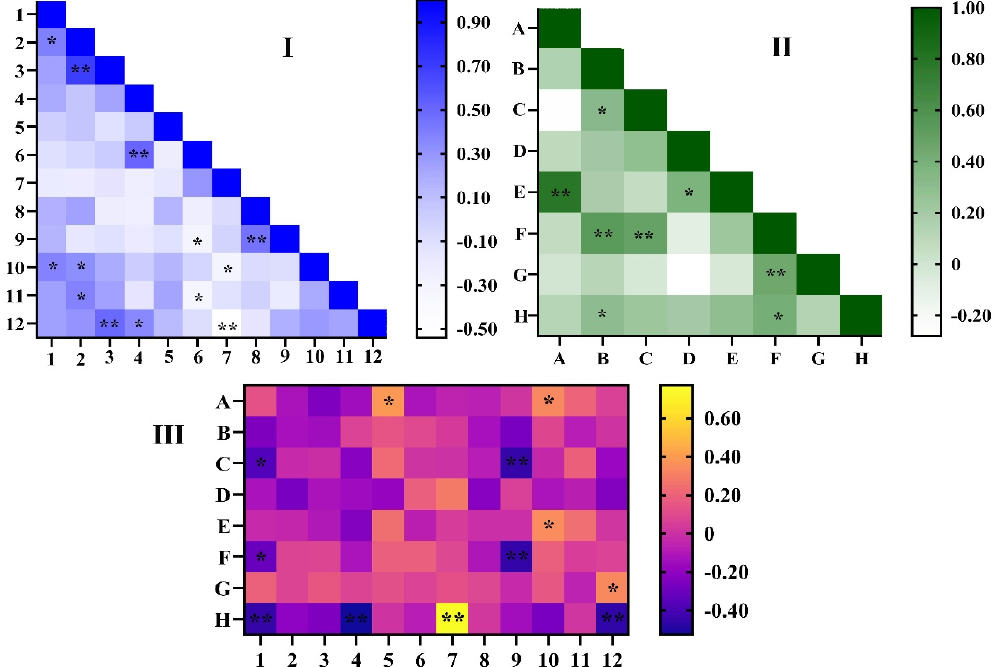
Figure 2. Correlation analysis between quality traits of H. acerba germplasms. ** indicated very significant correlation ( p < 0.01), * indicated significant correlation ( p < 0.05). Ⅰ : Correlation analysis between infructescence quality traits of H. acerba germplasms; Ⅱ : Correlation analysis between fruit quality traits of H. acerba germplasms; Ⅲ : Correlation analysis between infructescence and fruit quality traits of H. acerba germplasms. 1: Infructescence fat content; 2: Infructescence protein; 3: In ‐ fructescence tannin; 4: Infructescence total flavonoid; 5: Infructescence total saponin; 6: Infructescence soluble sugar; 7: Infructescence reducing sugar; 8: Infructescence starch; 9: Infructescence Mn; Fruit tannin; D: Fruit total flavonoid; E: Fruit total saponin; F: Fruit soluble sugar; G: Fruit reducing sugar; H: Fruit starch.